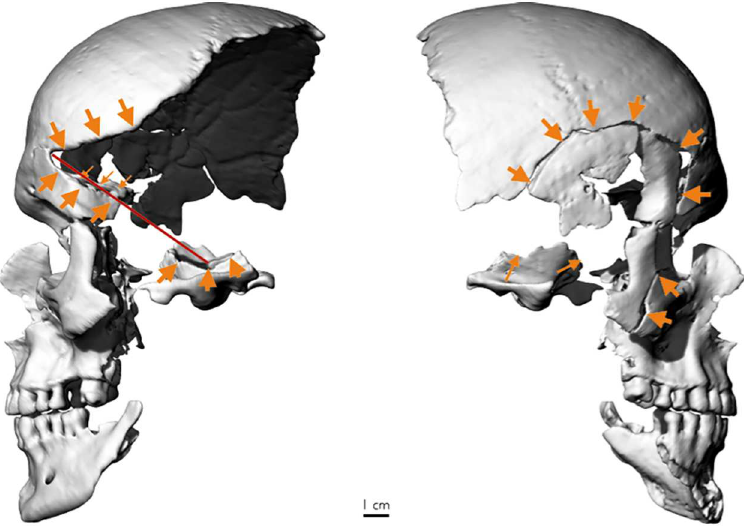
Fig 9. CT based three-dimensional reconstruction of the skull. (a) Left lateral view, showinga 7 cm long wedge-shaped notch that runs from the regionabovethe left eye to the left ear. Small arrows indicate the fracture of the inner side of anterior cranial fossa. (b) Right lateral view. The extensive impressionfracture of the right temple is well visible